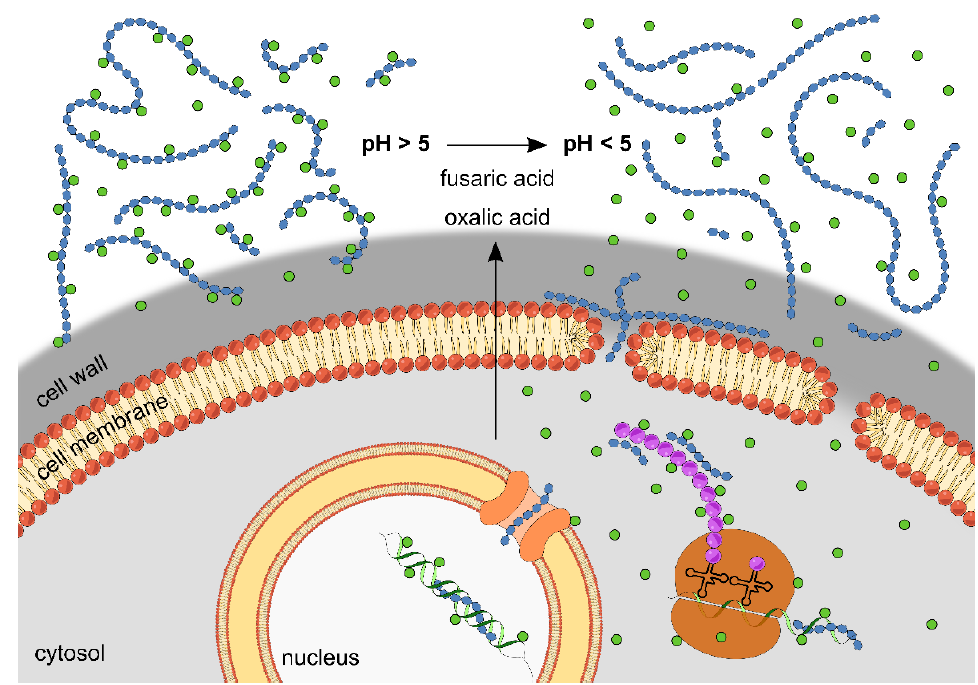
Figure 6. Potential mode of action of the synergistic antifungal activity of copper(II) ions and chitosans. The antifungal activity of copper(II) ions is based on ion uptake into the cell, followed by interaction with various chemical groups, ultimately disrupting the function of enzymes and other proteins, as well as nucleic acids. Chitosan polymers may be able to interact with or penetrate the fungal cell wall, which leads to destabilization of the membrane and uptake of chitosan oligomers into the fungal cell [18]. This also facilitates copper(II) ion uptake into the cell, explaining their synergistic action with membrane-permeabilizing chitosans. With a decrease in pH value by medium acidification, which is caused by the fungus, copper(II) ions increasingly dissociate from chitosan molecules, further enhancing the antifungal activity.